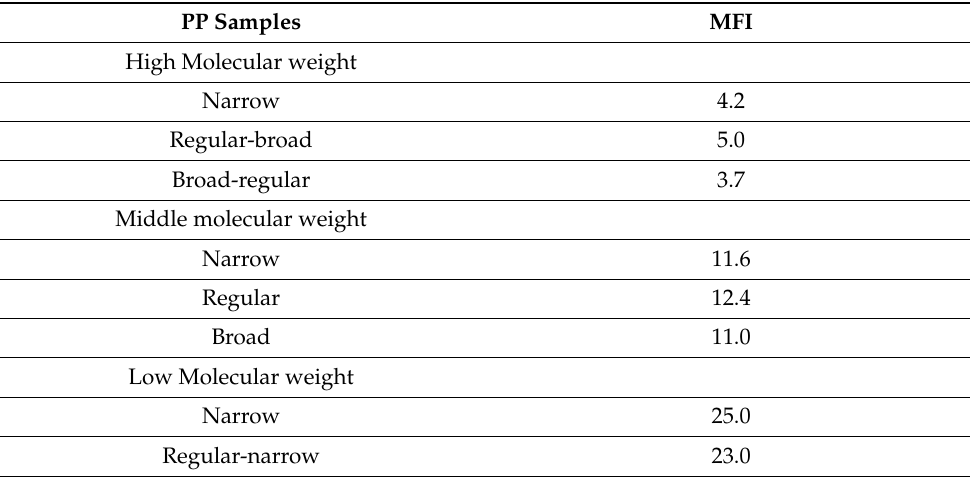
Table 3. MFI values for polypropylene samples with molecular weight